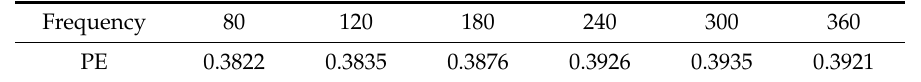
Table 1. The permutation entropy values corresponding to different noise amplitude. Amplitude